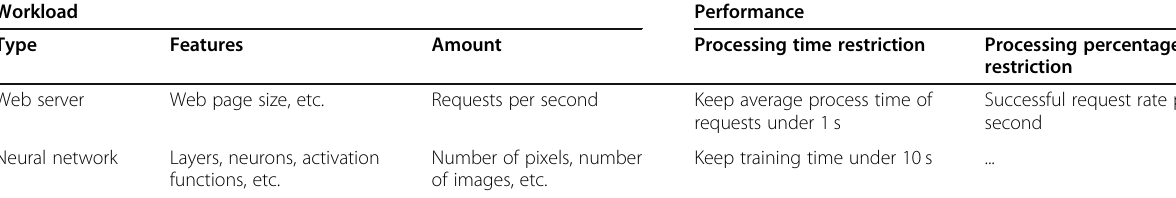
Table 2 Example of workload and performance requirements